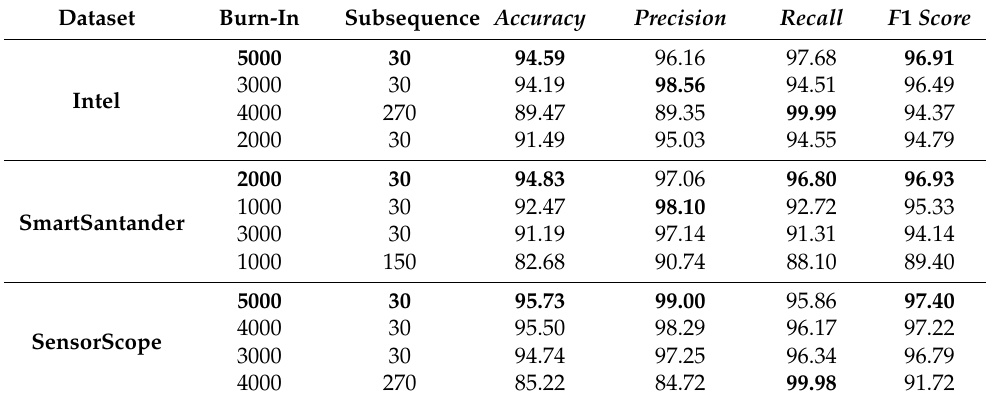
Table 5. Parameter sensitivity analysis (best results for each metric are highlighted in bold).